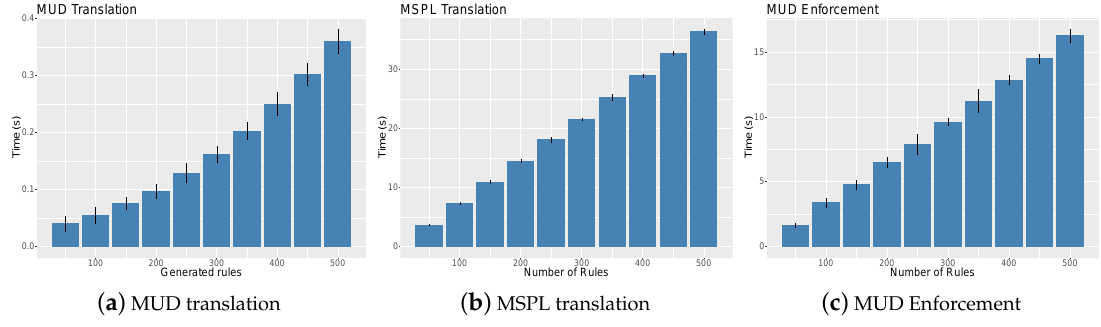
Figure 6. MUD translation and enforcement